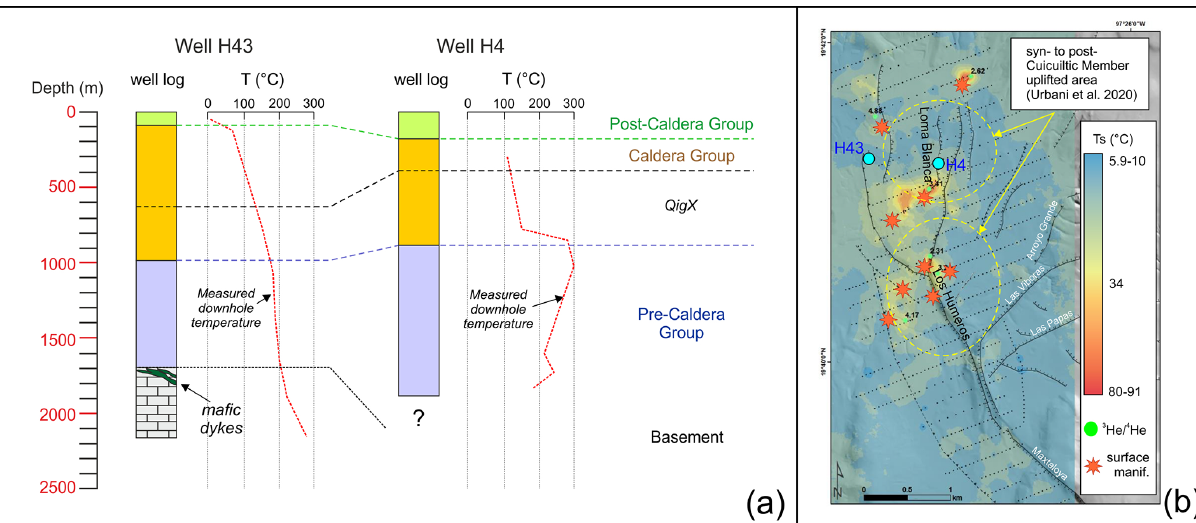
Figure 4. (a) In-depth correlation of lithostratigraphic units for the H4 and H43 geothermal wells (after Areallano et al., 2003; Carrasco- Núñez et al., 2017b; Urbani et al., 2020). Measured downhole temperature profiles for well H4 (Torres-Rodriguez, 1995; Prol-Ledesma, 1988, 1998; Martínez-Serrano, 2002) and well H43 (Lorenzo-Pulido, 2008) are reported. (b) Interpolation map of soil temperatures measured at Los Potreros caldera (modified after Jentsch et al., 2020; GEMex, 2019a). Orange stars showing locations of hydrothermal surface manifestations are after Jentsch et al. (2020). Geothermal wells H4 and H43 are also reported. Yellow dashed ellipses indicate the syn- to post-Cuicuiltic Member eruption uplifted area as proposed by Urbani et al.